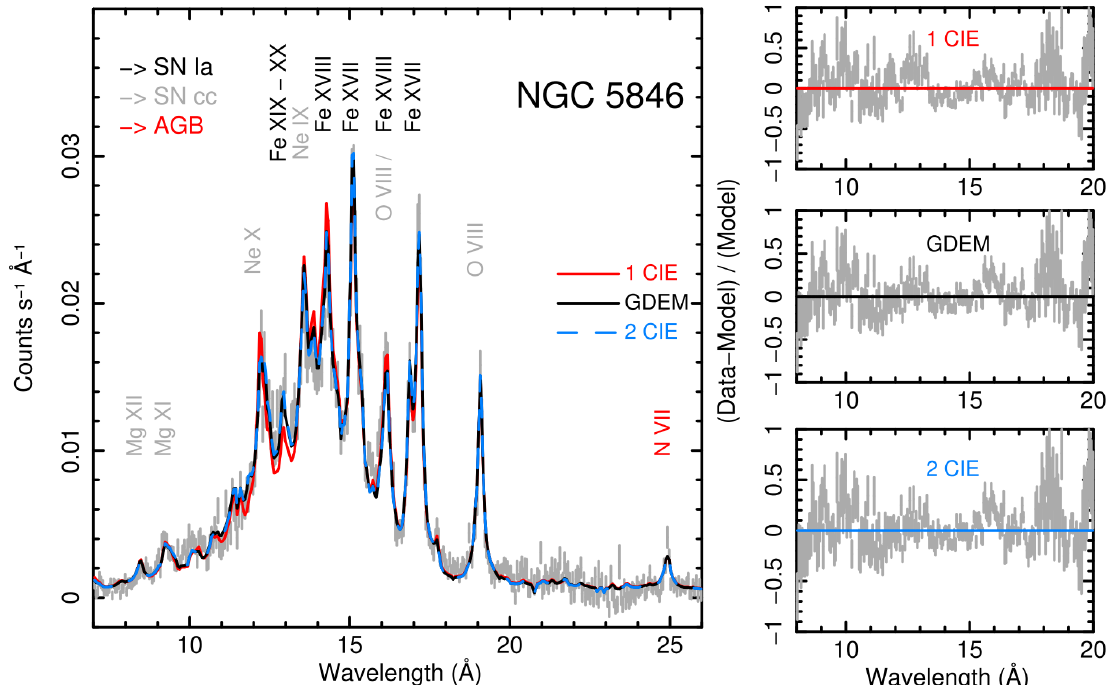
Figure 9. An example of RGS spectrum from a deep observation of NGC5846, with indication of its main emission lines (and the stellar origin of their corresponding element). Spectra from the RGS1 and RGS2 instruments were combined before successive fits assuming models with one temperature (1CIE), two temperatures (2CIE), and a Gaussian-like multi-temperature structure (GDEM). Residuals are shown in the right panels. Figure reproduced with permission from de Plaa et al.